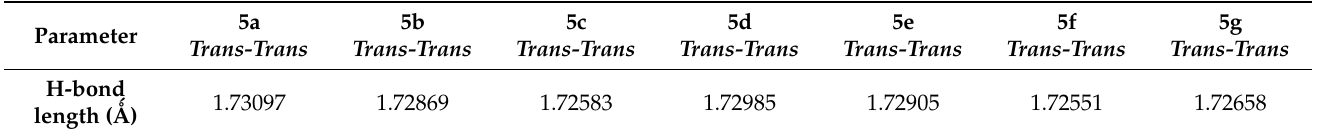
Table 2. Predicted H-bond length calculated by DFT at B3LYP 6-311G (d,p) basis set for 5a – g .